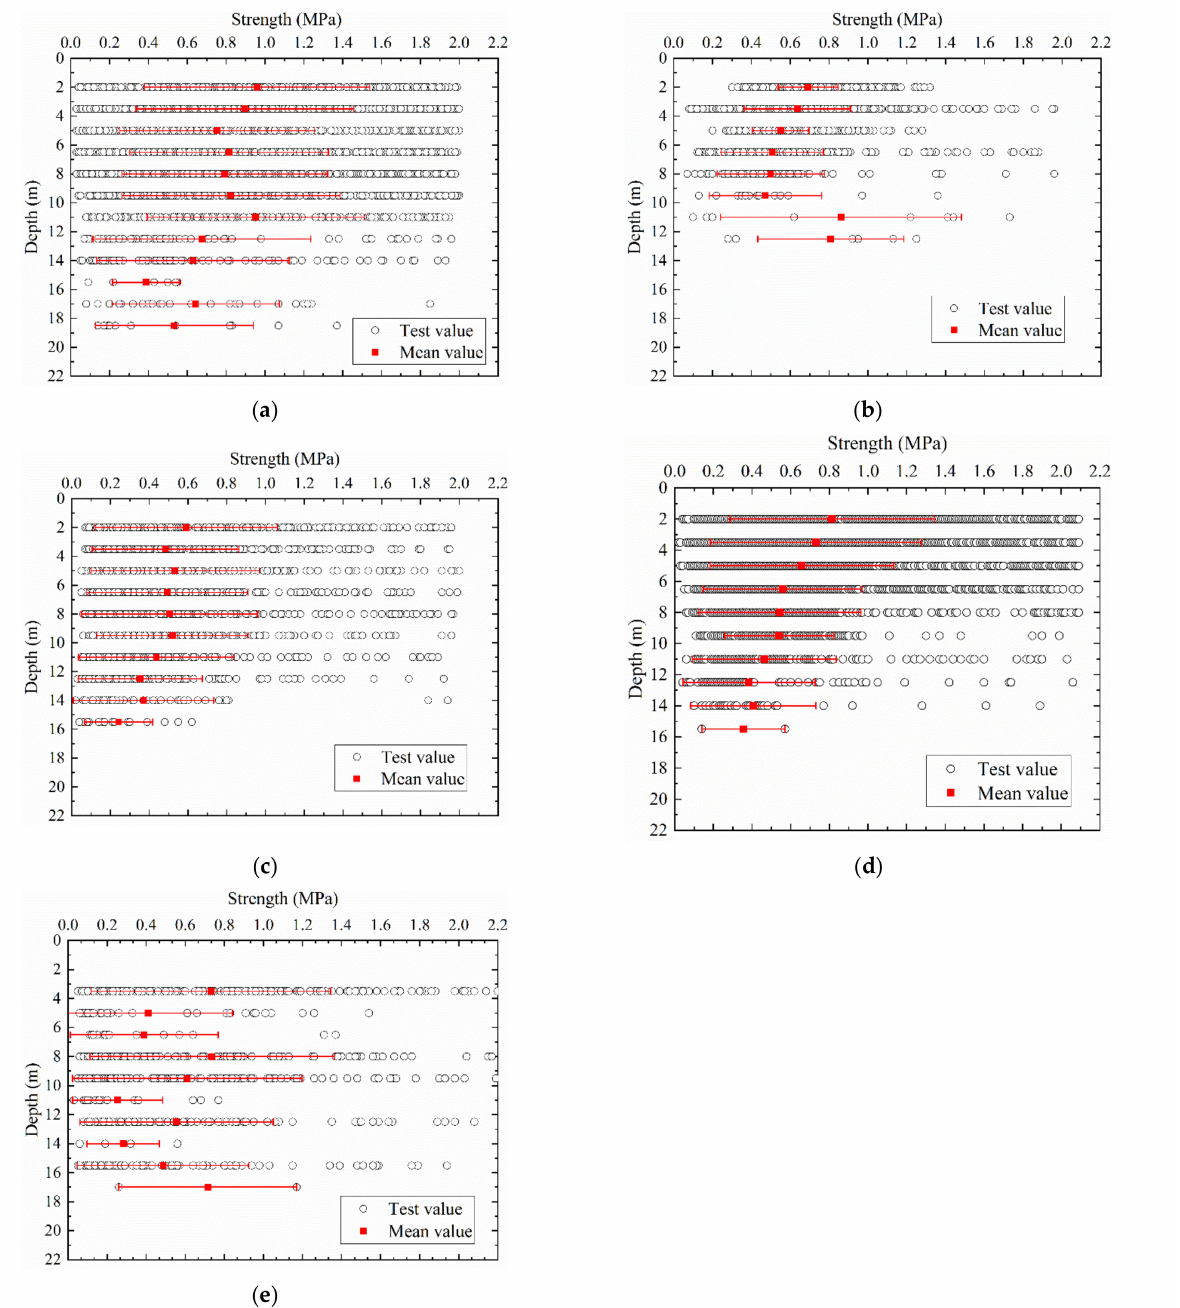
Figure 4. Relationship between strength and depth: ( a ) littoral soft soil; ( b ) lagoon soft soil; ( c ) alluvial soft soil (Ancient Yellow River); ( d ) alluvial soft soil (Yangtze River); ( e ) lacustrine soft